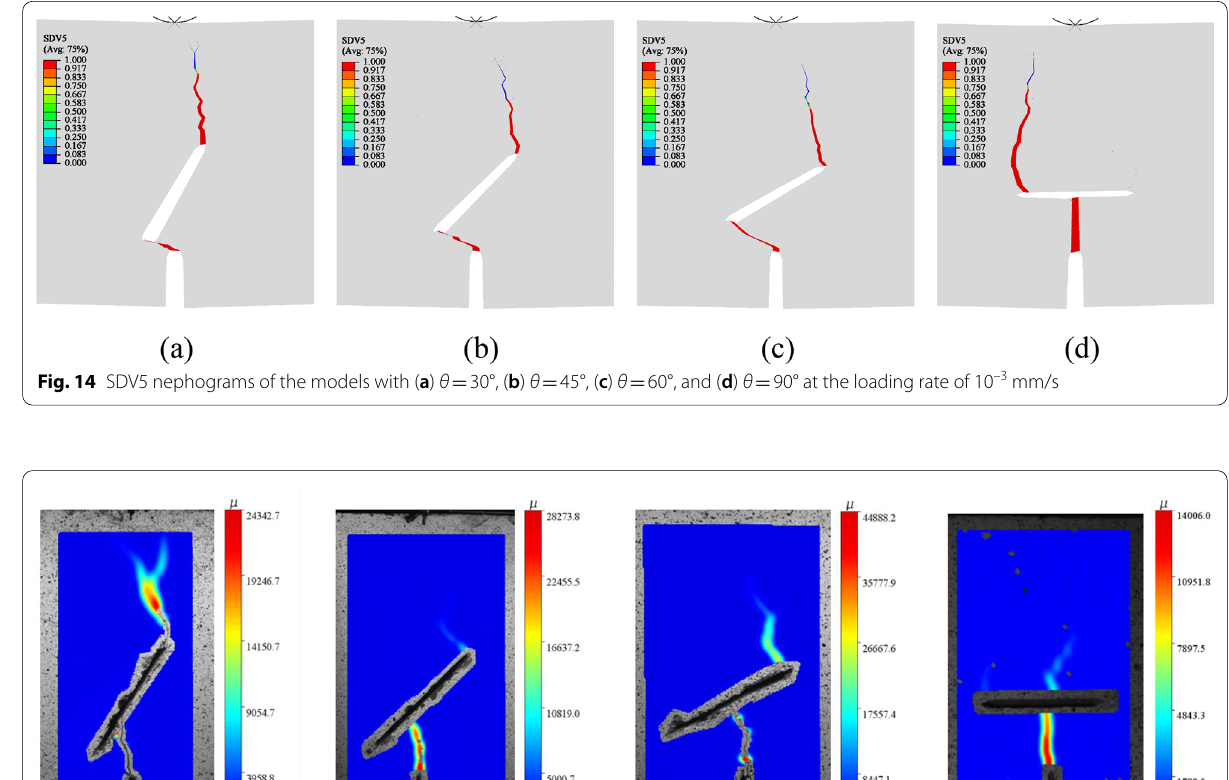
30°, ( b ) θ 45°, ( c ) θ 60°, and ( d ) θ 90° at the loading rate of = = = =